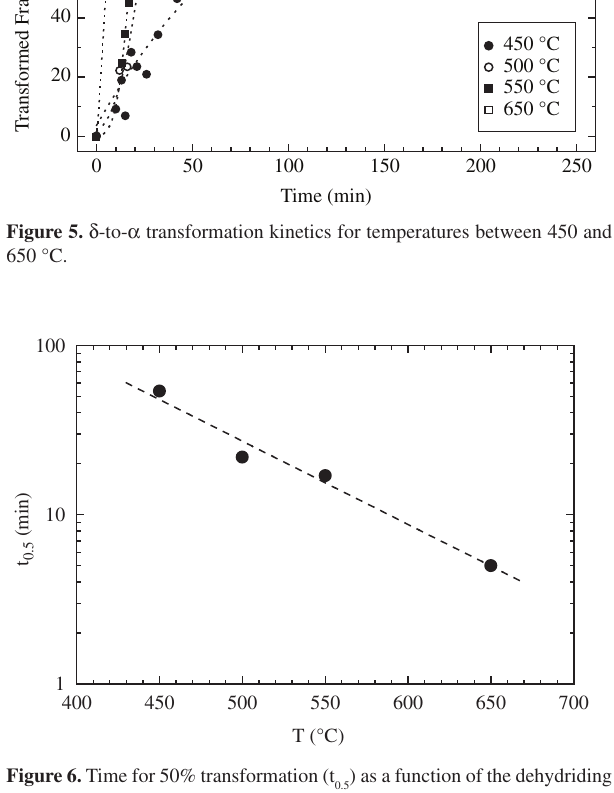
) as a function of the dehydriding 0.5